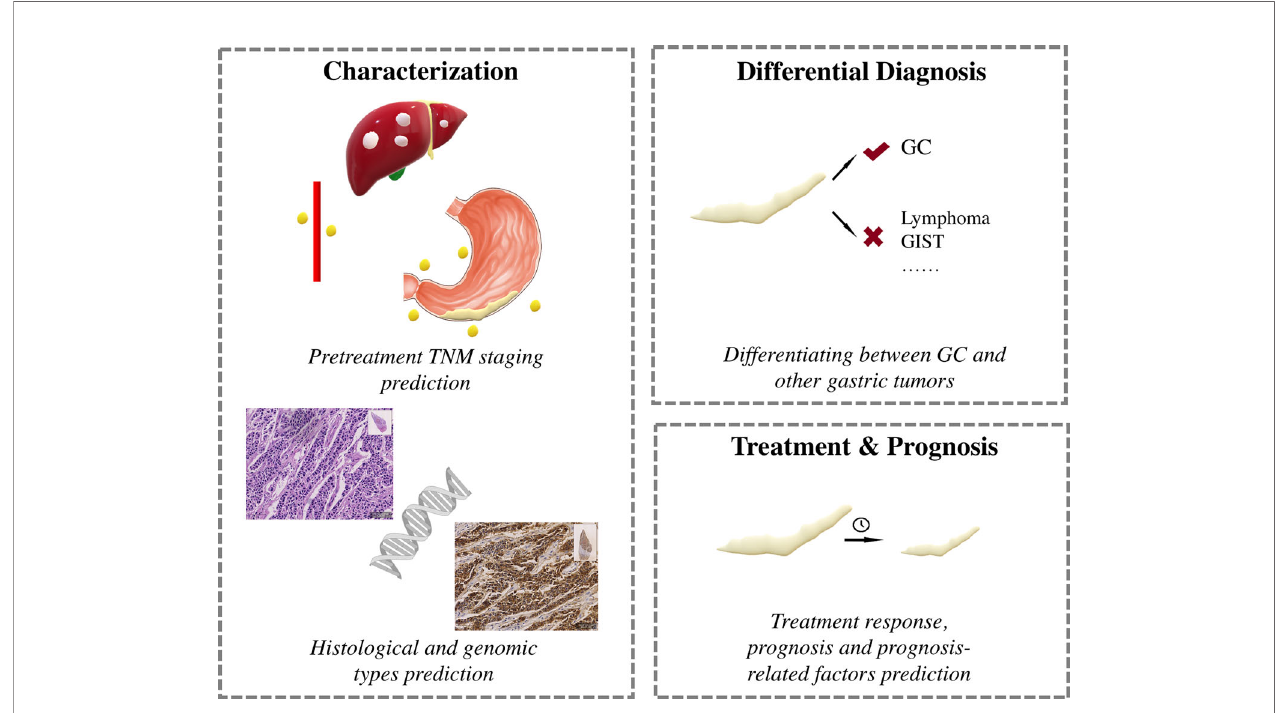
FIGURE 2 | Clinical application of hand-crafted radiomics and deep learning in gastric